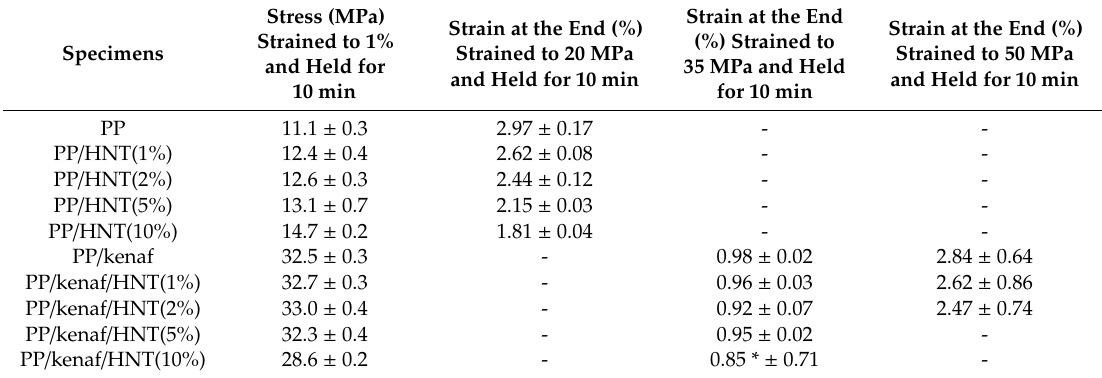
Table 3. Creep test results for the PP, PP / HNTs NCs, PP / kenaf biocomposite, and PP / kenaf / HNTs